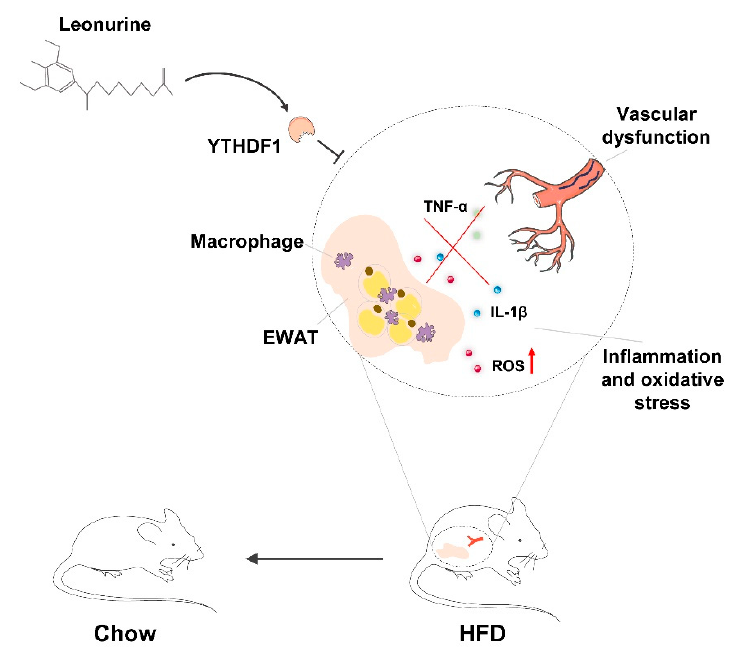
Figure 6. Schematic diagram of the mechanism of LEO alleviating oxidative stress in adipose tissue and vascular dysfunction of obese mice.